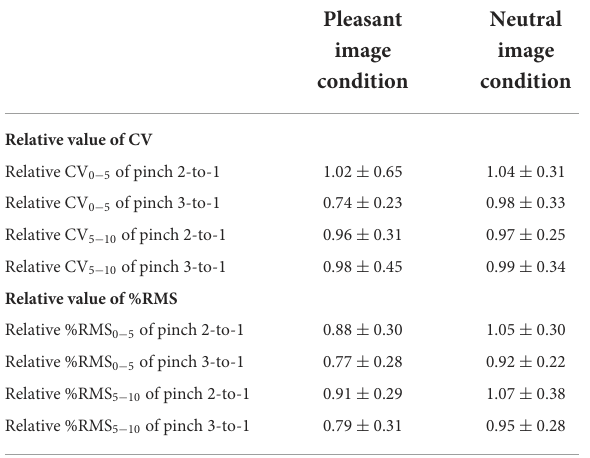
TABLE 4 Relative values of CV and %RMS in the pleasant and neutral image conditions.